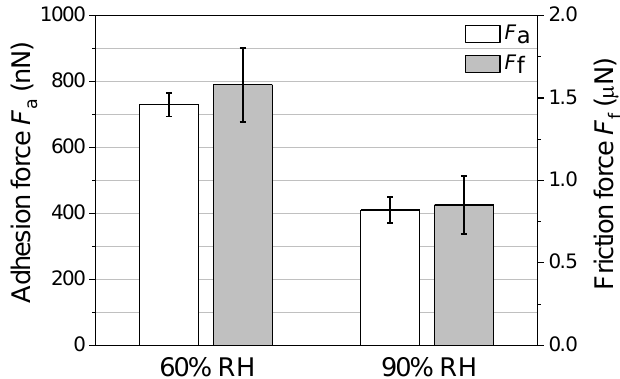
Figure 5. Adhesion force F a and friction force F f on silicon sample surface between 60% RH and 90%